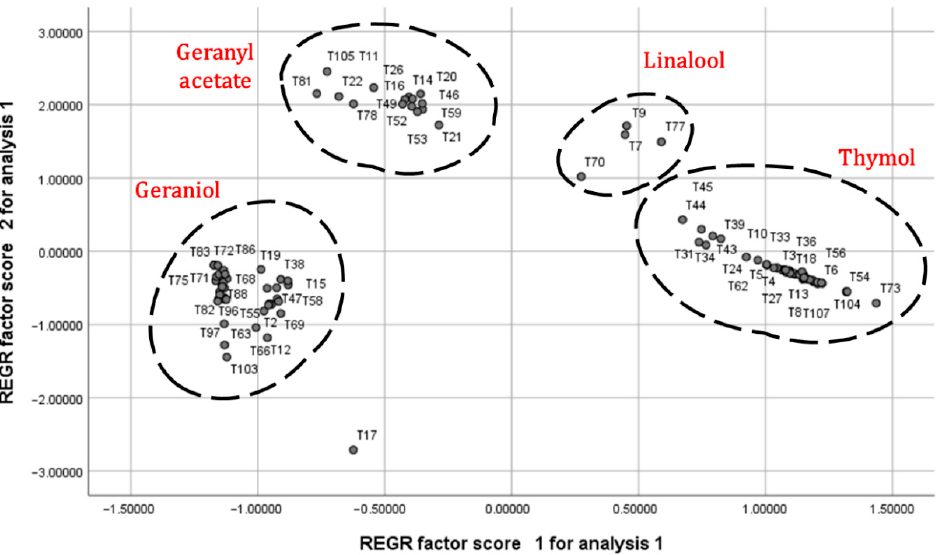
Figure 2. Scatter plot showing the similarity relationships among 103 individuals of T. quinquecostatus essential oils.